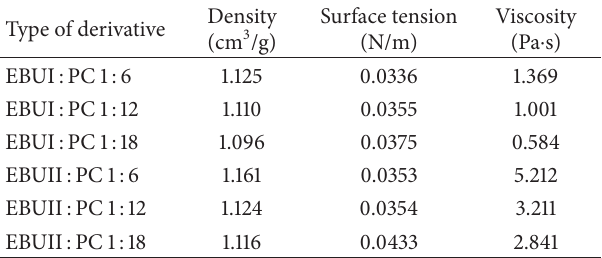
Table 7: Physical properties of reaction products of EBU with PC measured at 20 ∘